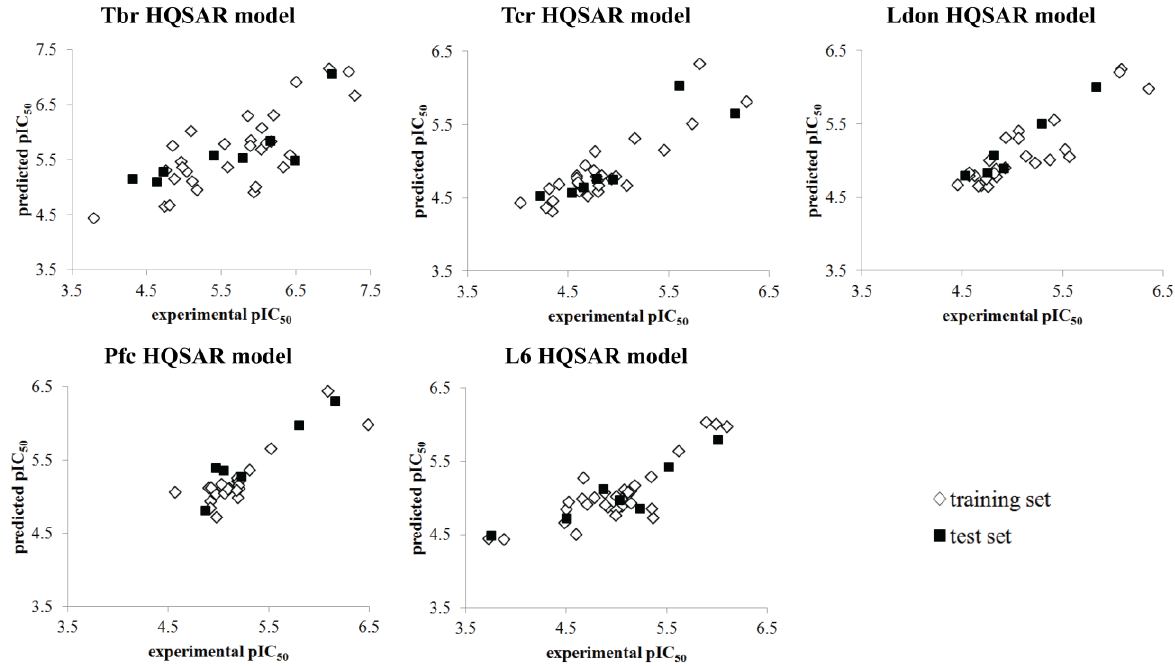
Figure 3. Experimental versus predicted pIC constructed HQSAR